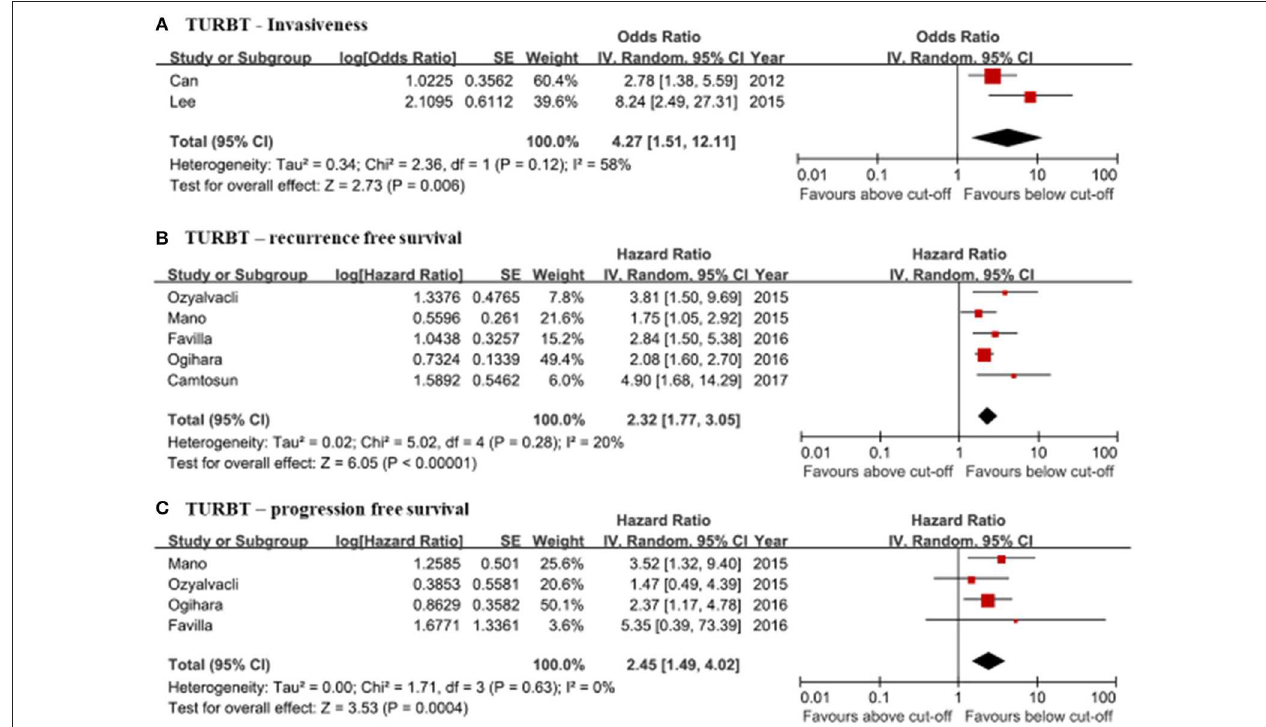
FIGURE 3 | Forrest plots of the relationship between neutrophil-to-lymphocyte ratios (NLR) and clinical information of the TURBT patients. (A) TURBT—Invasiveness. (B) TURBT—recurrence free survival. (C) TURBT—progression free